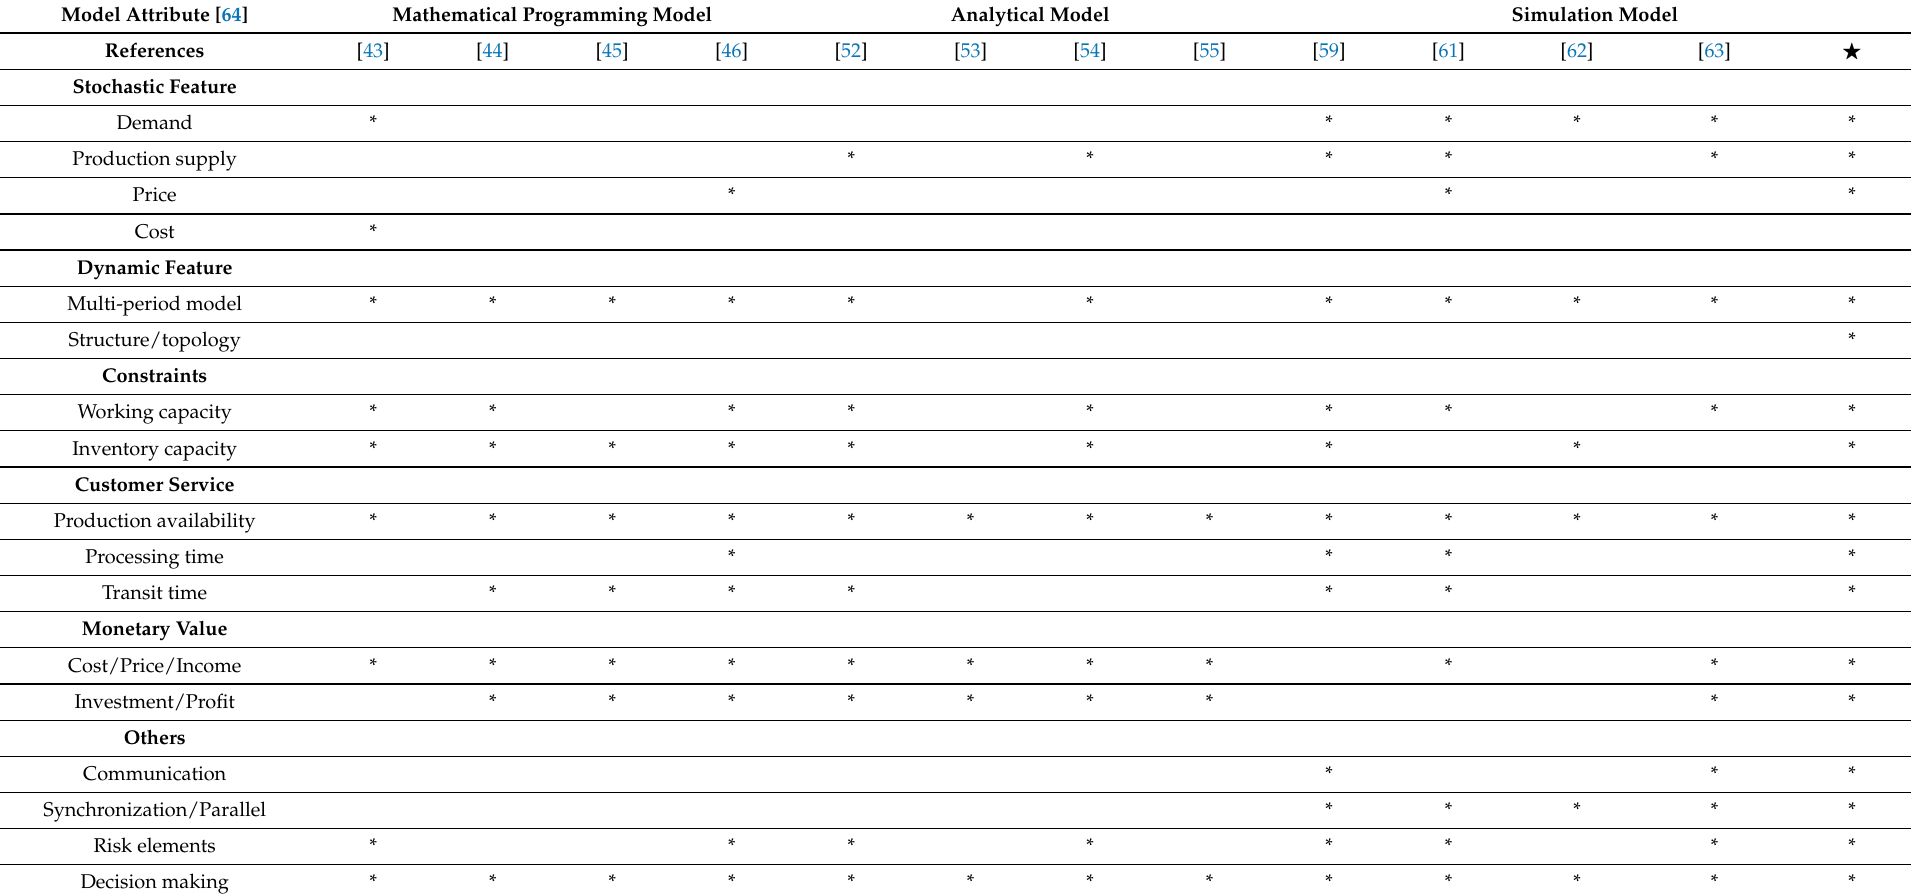
Table 1. The main features of our ABM compared with the existing